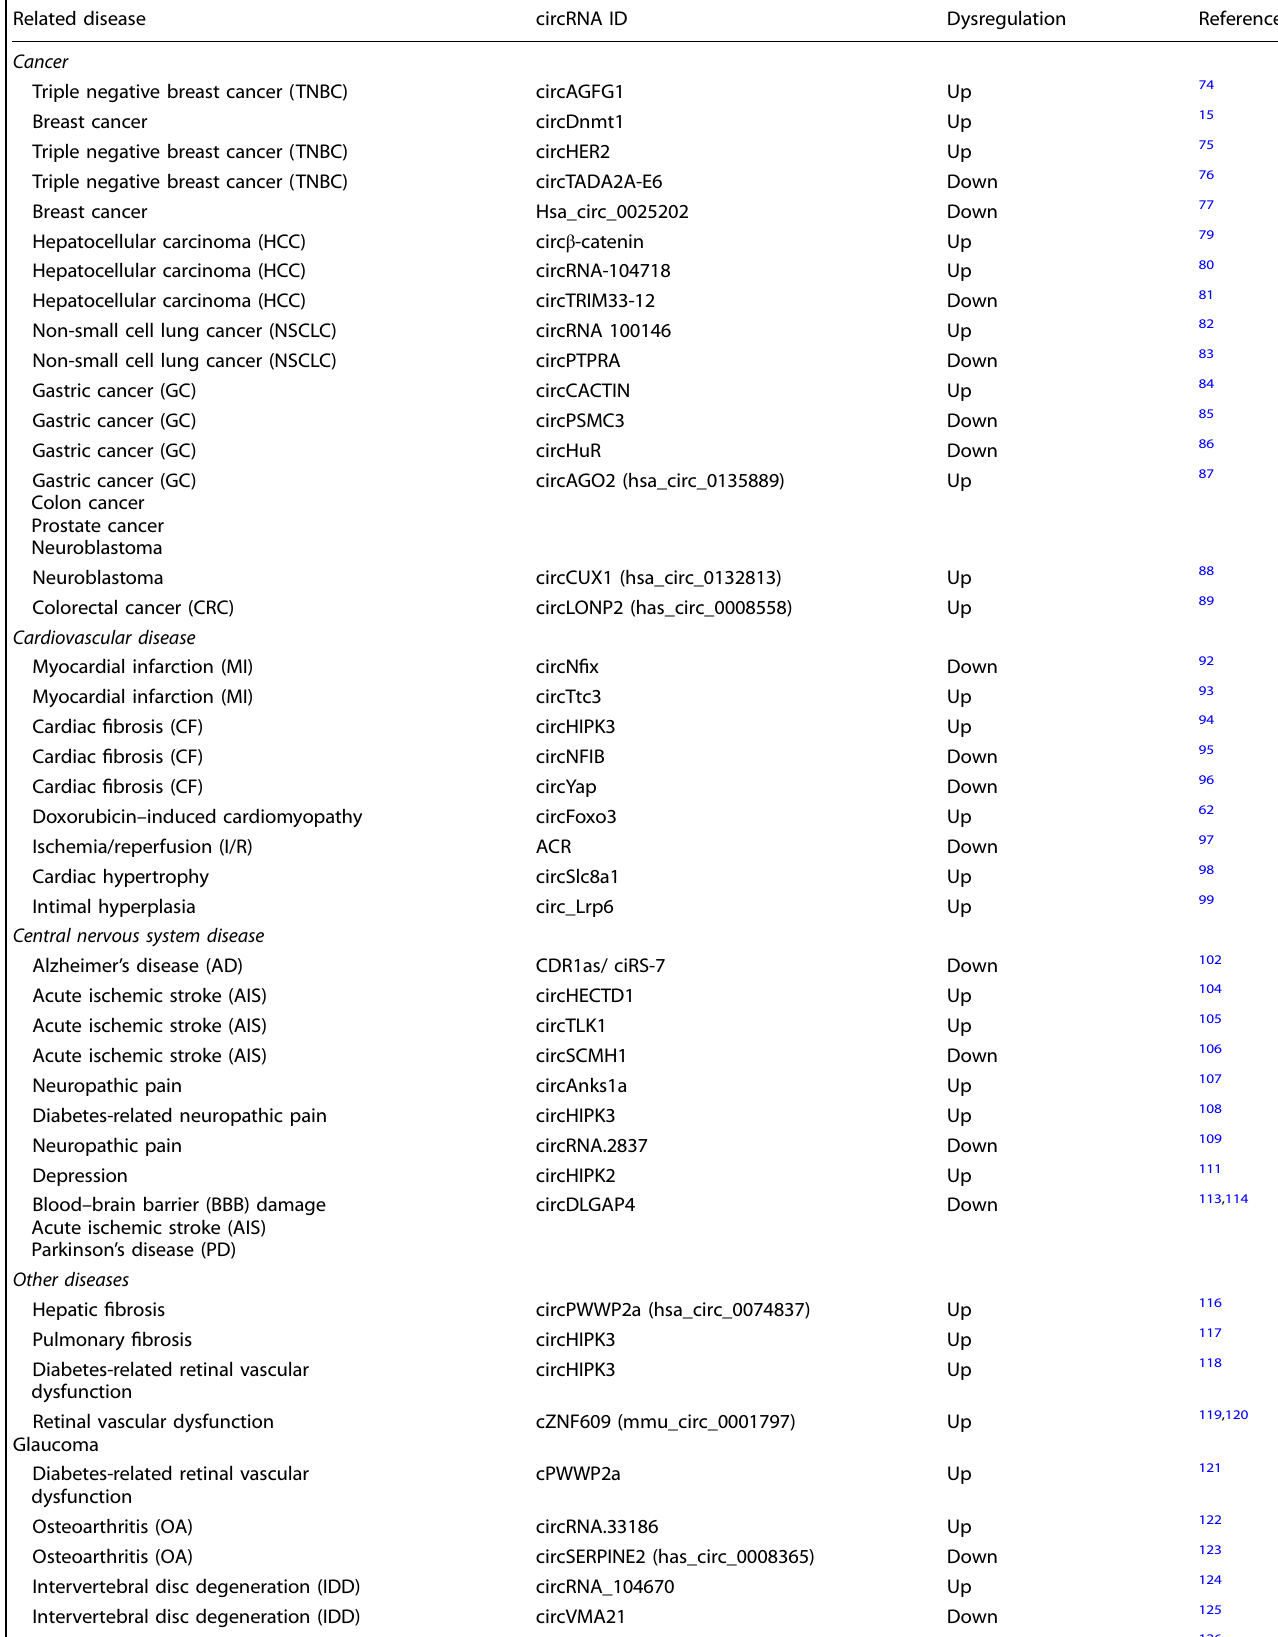
Table 1. Dysregulated circRNAs that have been targeted in diseases Related